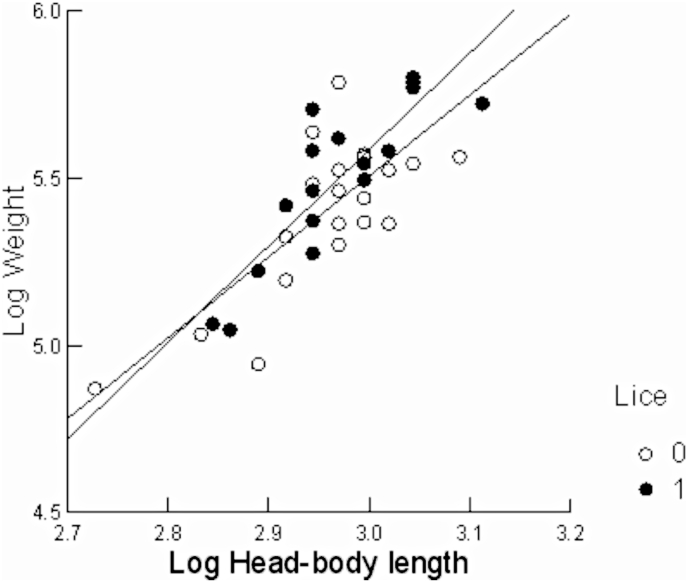
Relationship between the natural logarithm of body mass and the natural logarithm of body length for Trinomys iheringi individuals infected and uninfected by lice in Ilha Grande State Park, RJ, Brazil. Open circles and the continuous line refer to uninfected individuals, while solid circles and the dashed line refer to infected individuals.